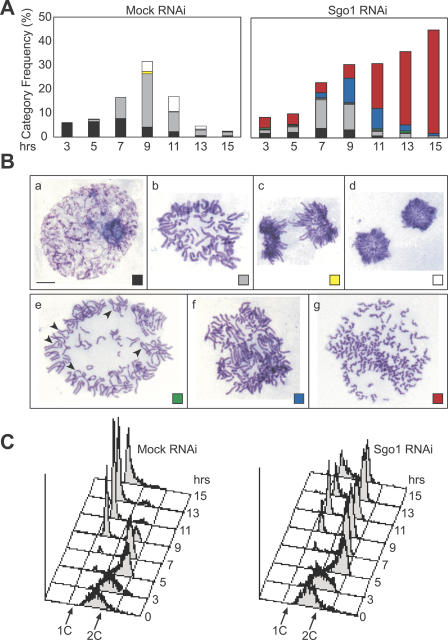
Sgo1 Depletion Causes Precocious Sister Separation and Mitotic ArrestSynchronised HeLa cells were transfected with Sgo1 siRNA or dH2O, harvested at 2-h intervals following release and examined by chromosome spreading and Giemsa staining. 100 cells were scored for mitotic index, and 100 mitotic cells were classified into seven categories based on chromosome configuration as exemplified in (B) for each time point.(A) The frequency of each category of mitotic cell is given as a percentage of total cell numbers, such that the sum of each column represents the mitotic index.(B) Representative pictures of seven categories of mitotic cells. Chromosome spreads: (a) prophase; (b) metaphase/metaphase-like; (c) anaphase; and (d) telophase. (e) Early phase of precocious sister disjunction. At this stage, sisters are beginning to separate and some or all presumptive sister pairs are still discernible. Arrowheads indicate chromosomes whose centromeric cohesion seems to be lost. (f) Later phases of sister chromatid separation. Sister pairs at this stage are no longer discernible, remnants of the metaphase plate are still visible, and sisters have not yet hypercondensed. (g) Scattered single chromatids. Sisters are completely separated and distributed randomly in relation to one another, individual chromatids are hypercondensed, giving a “curly” appearance. Note that chromatid separation in normal anaphases (c) are different from precocious sister chromatid separation (e–g), in that disjoined and paired chromatids coexist in the same cell.(C) A portion of the cells harvested for the analysis in Figure 3A and 3B were ethanol-fixed and their DNA content was analysed by flow cytometry.